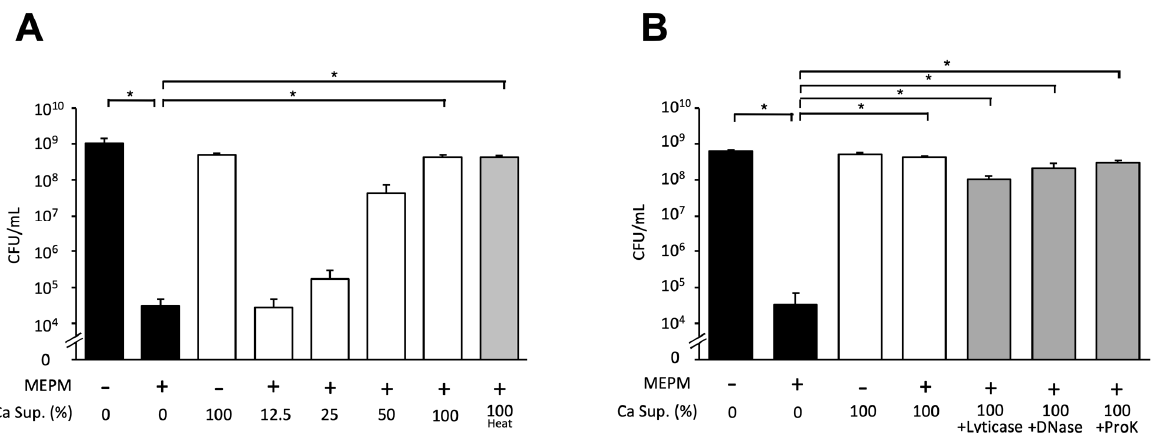
Figure 5. Effects of Candida culture supernatant treated with heat and hydrolytic enzymes on E. coli biofilm formation in the presence of MEPM. ( A ) E. coli RB ‐ 3 survival in the presence of 50 μ g/mL MEPM and various concentrations of Candida culture supernatant (Ca Sup.; 0%, 12.5%, 25%, 50%, and 100% v / v ) under each treatment and heating at 100 °C for 30 min; ( B ) culture supernatant (Ca Sup.) was treated with 50 μ g/mL lyticase ( β 1,3 ‐ D ‐ glucanase) at 25 °C for 8 h, 50 μ g/mL DNase at 37 °C for 8 h, or 50 μ g/mL proteinase K at 37 °C for 8 h. Measurements were performed three times and the data are the means ± standard deviations. n = 3/group. Statistically significant differences between groups were evaluated using Tukey’s test with one ‐ way ANOVA; * p < 0.05.